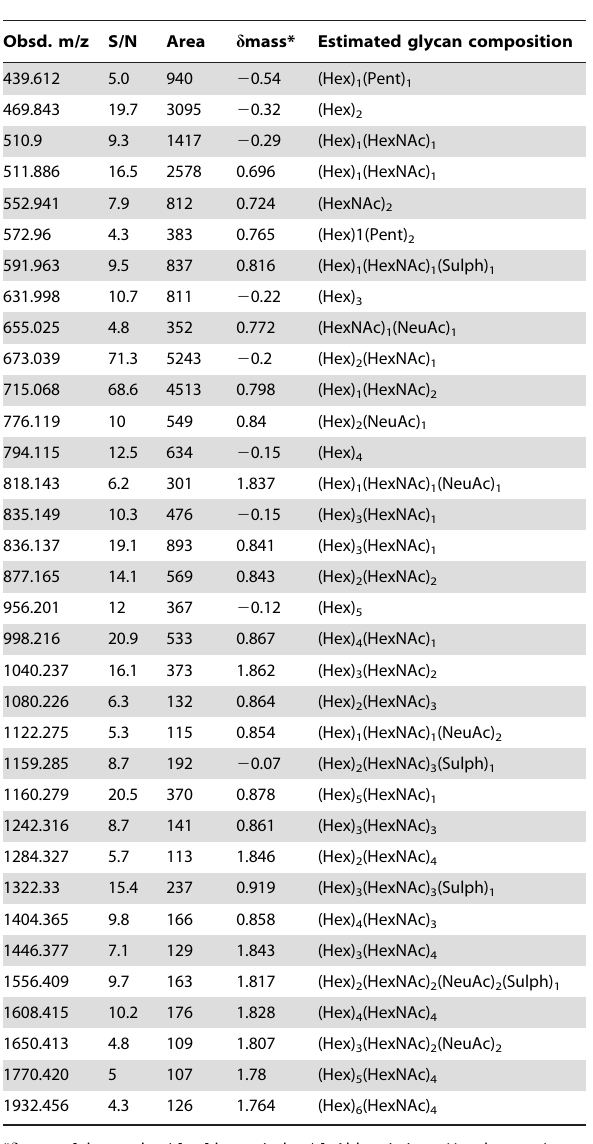
Table 1. Estimated O-glycan compositions of SRf1 from mass spectrometric data.